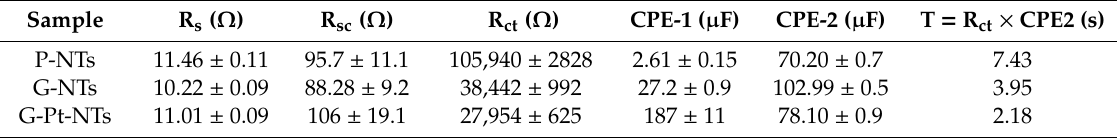
Table 1. Equivalent circuit components calculated by fitting the experimental electrochemical impedance spectroscopy